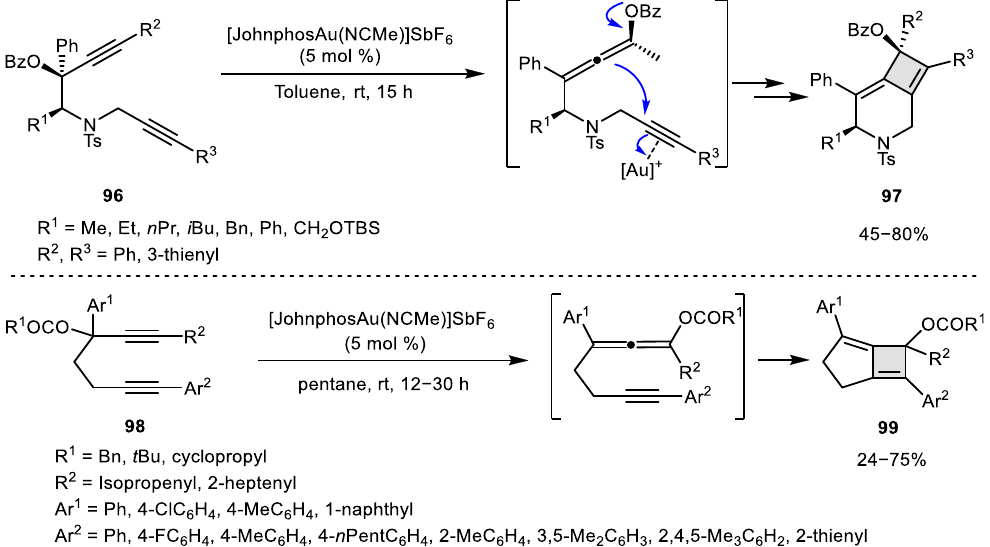
Scheme 32. Gold-catalyzed intramolecular [2+2] cycloaddition of diynes towards